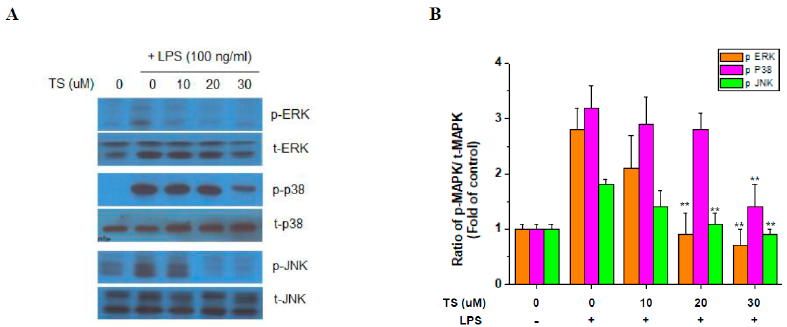
Figure 5. Effect of TS on activated MAP kinases in LPS-activated RAW 264.7 cells. Cells were pretreated with TS at the indicated concentrations for 1 h and stimulated with LPS (100 ng/mL) for 8 h. The cells were then harvested and subjected to western blotting. ( A ) Phosphorylated extracellular-signal-regulated kinase (ERK), p38, and c-Jun N-terminal kinase (JNK) were analyzed by western blotting analysis of cells treated with 10, 20, and 30 μ M TS; ( B ) Western signals of phosphorylated MAP kinases were normalized by the expression of total MAP kinase expression. Relative expressions of phosphorylated MAP kinases were quantified from three independent experiments. ** p < 0.01 vs. LPS-treated sample. − : No treatment; +: LPS-treated.